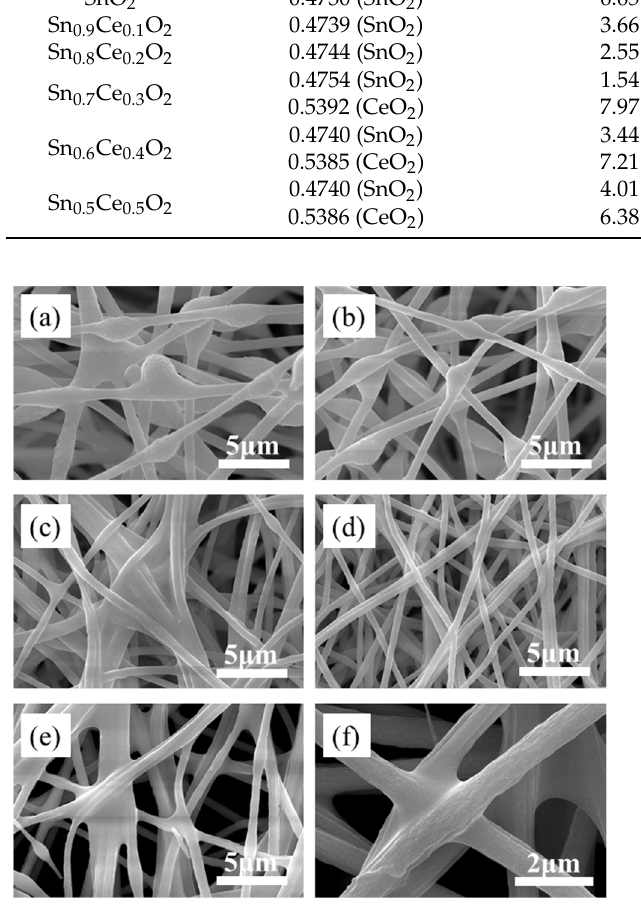
Figure 3. SEM images of ( a ) Sn 0.9 Ce 0.1 O 2 , ( b ) Sn 0.8 Ce 0.2 O 2 , ( c ) Sn 0.6 Ce 0.4 O 2 , ( d ) Sn 0.5 Ce 0.5 O 2 , and ( e , f ) Sn 0.7 Ce 0.3 O 2 fibers.